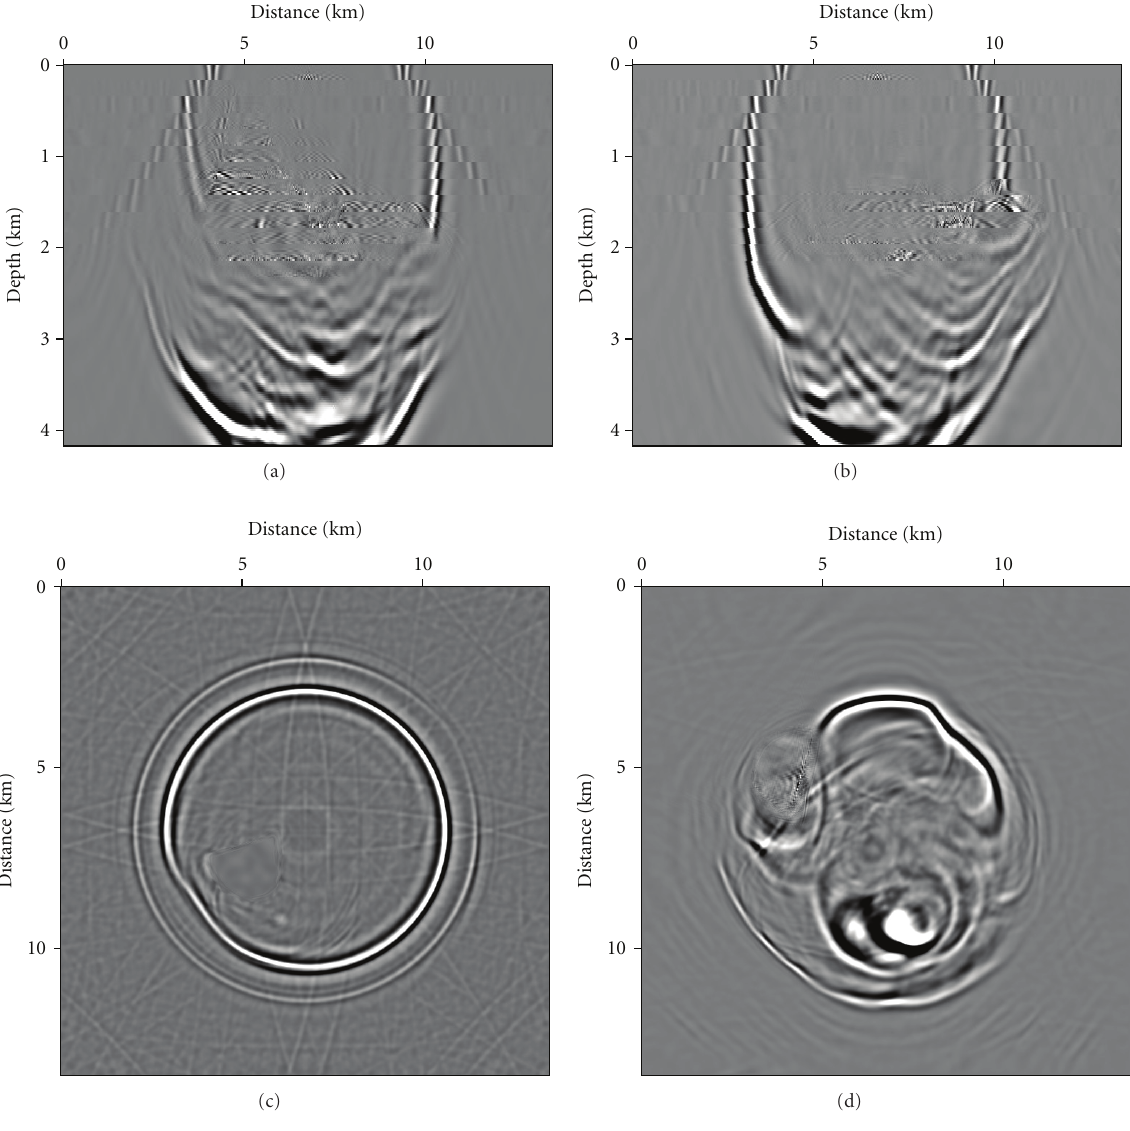
Figure 4: Impulse response obtained by FD migration using the real Pad ´ e approximation with 1 term and Li correction (cross-sections as